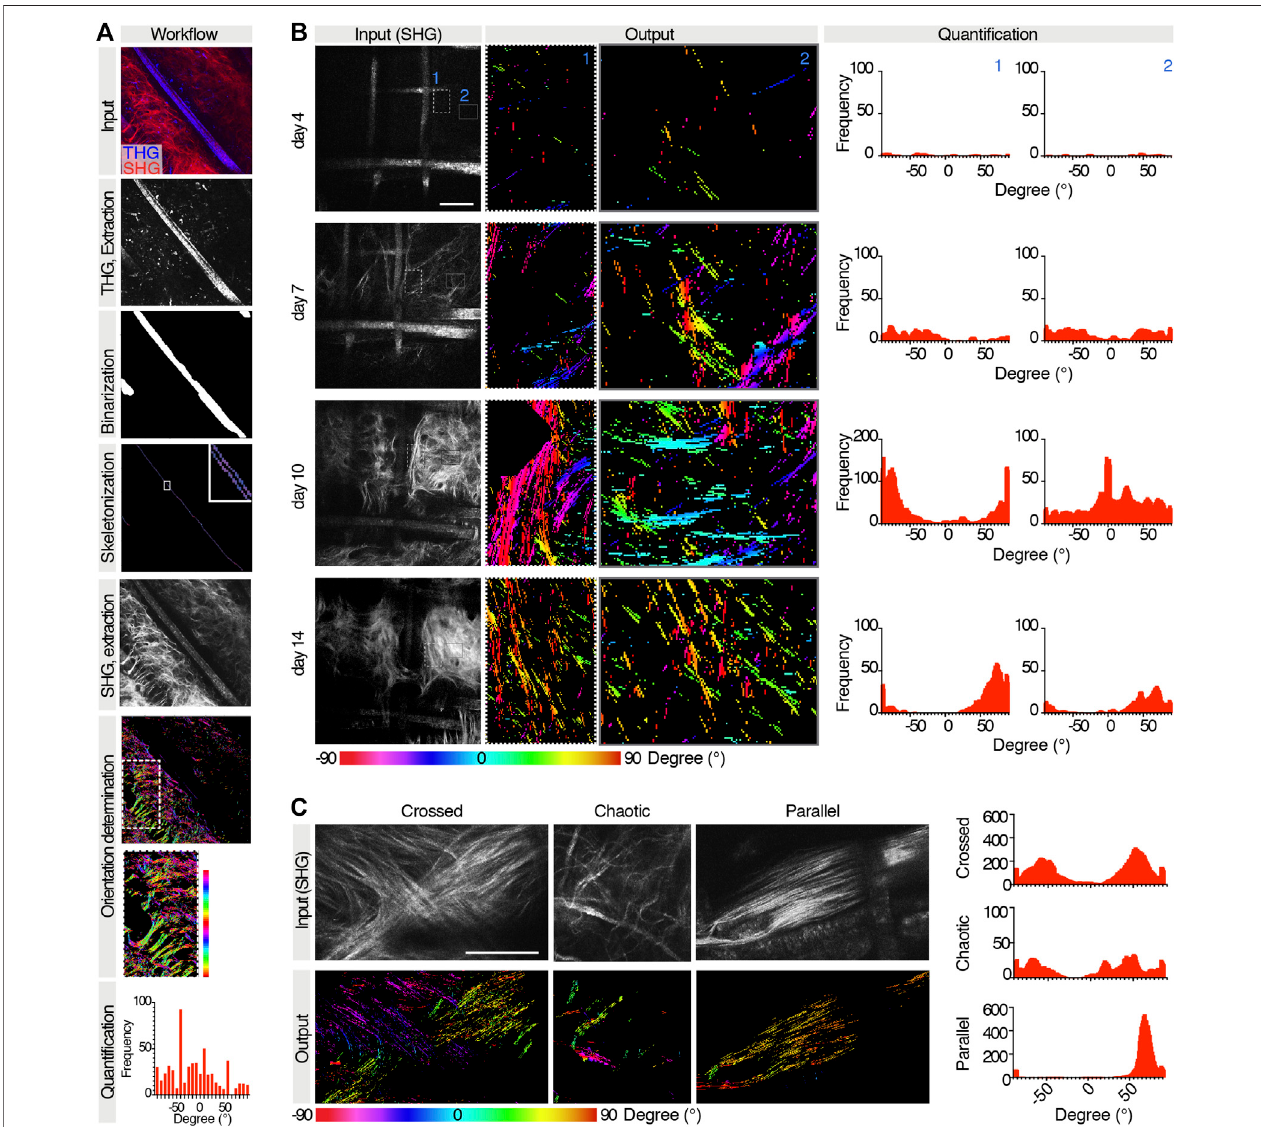
FIGURE 5 | Extraction of collagen orientations relatively to the scaffold. (A) Work fl ow for extraction of collagen orientations relative to scaffold for a given case test. Top to bottom: raw input collagen and scaffold image (SHG and THG channels); THG channel extraction and skeletonization; SHG channel extraction and colormap of orientations of collagen boundaries in the whole image and in the subregion of interest where collagen directionalities are quanti fi ed; resulting histogram and frequency distributionrelativetothepredominantscaffoldorientation. (B) Extractionofcollagenorientationsinthesameregionatdays4,7,11,and14post-implantation.For each time point, a raw input collagen image (gray), a color map of orientations of two subregions, and the relative histograms are shown. (C) Extraction of collagen orientations in regions with different patterns of collagen bundles. For each pattern, the raw input collagen image (gray), the output colormap, and the histogram of frequency are